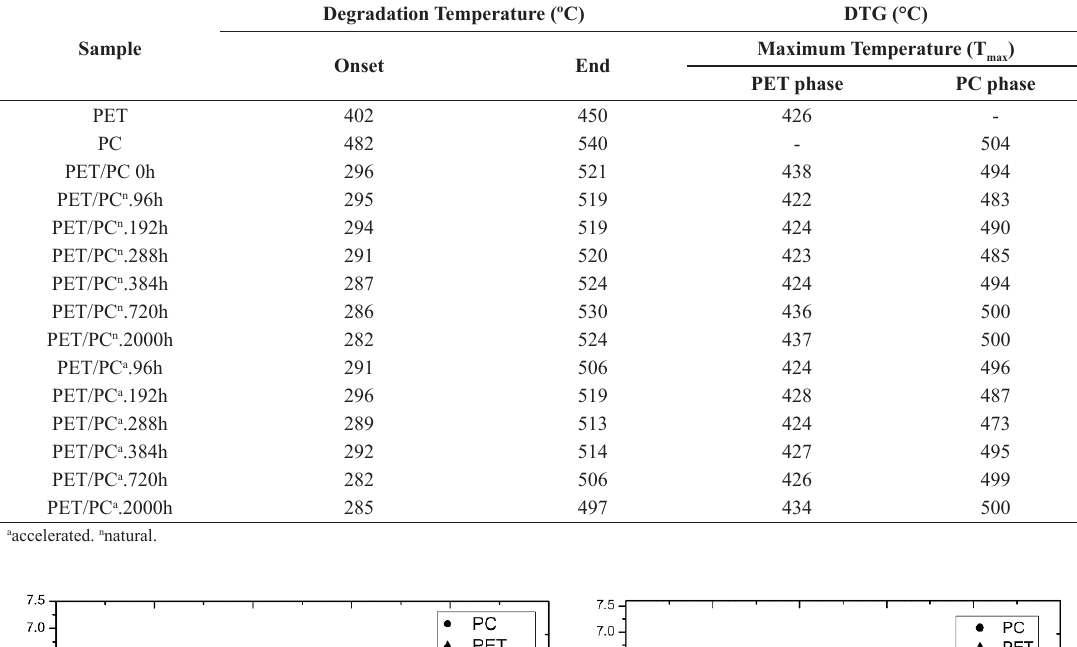
Table 1. Representative TGA data of the PET, PC and the blend, under natural and accelerated aging.